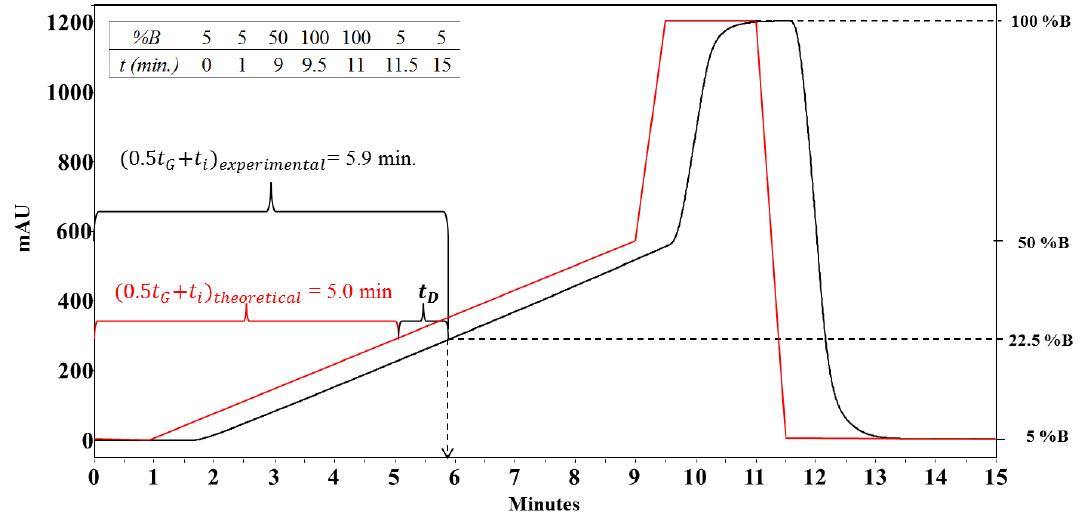
Figure 1. Dwell time determination [26–28]. Programed elution gradient (red line), experimental gradient performed by the HPLC system (black line). Delay time (t i ), gradient time (t G ), dwell time (t D ).